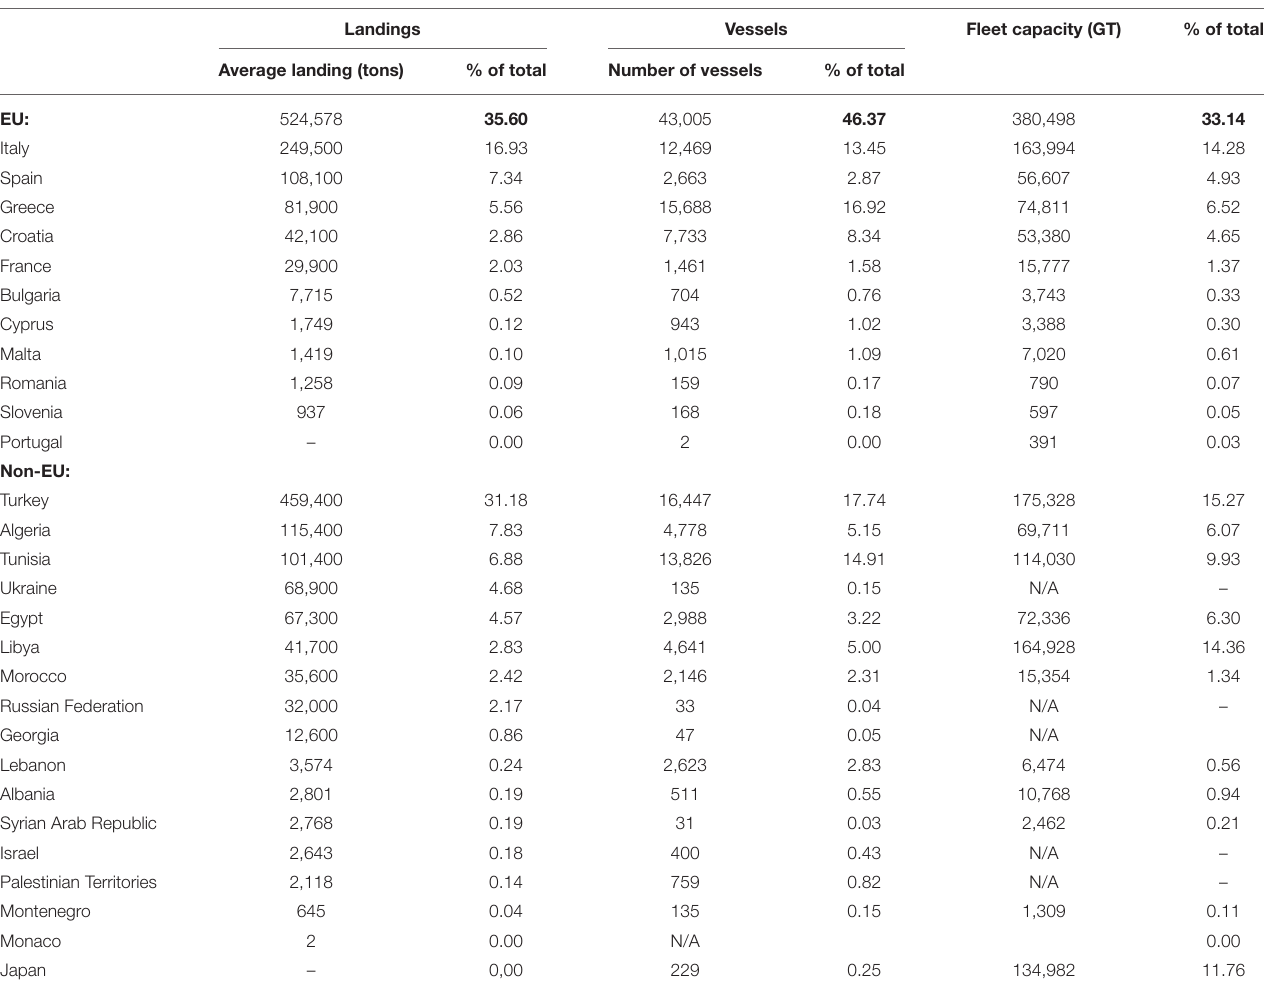
TABLE 1 | Summary of reported landings, vessels, and fleet capacity of GFCM contracting parties, cooperating non-contracting parties, non-contracting parties, or relevant non-State actors in the Mediterranean and Black Seas.